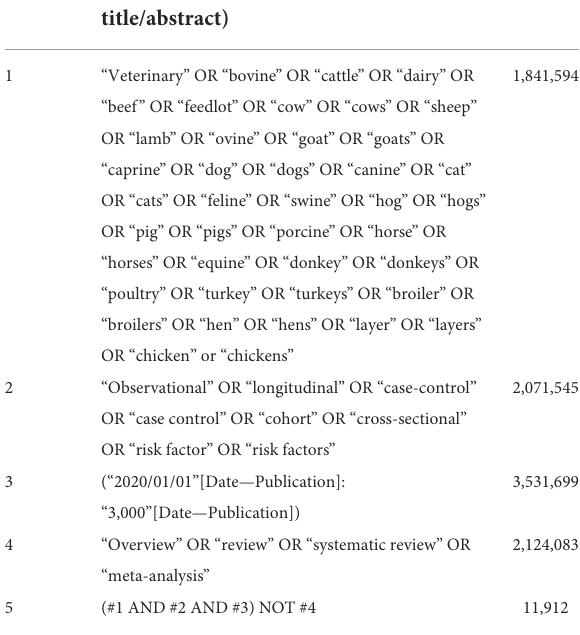
TABLE 1 Search to identify veterinary observational studies published after January 1, 2020 in Medline ® ( via PubMed) conducted on March 31,